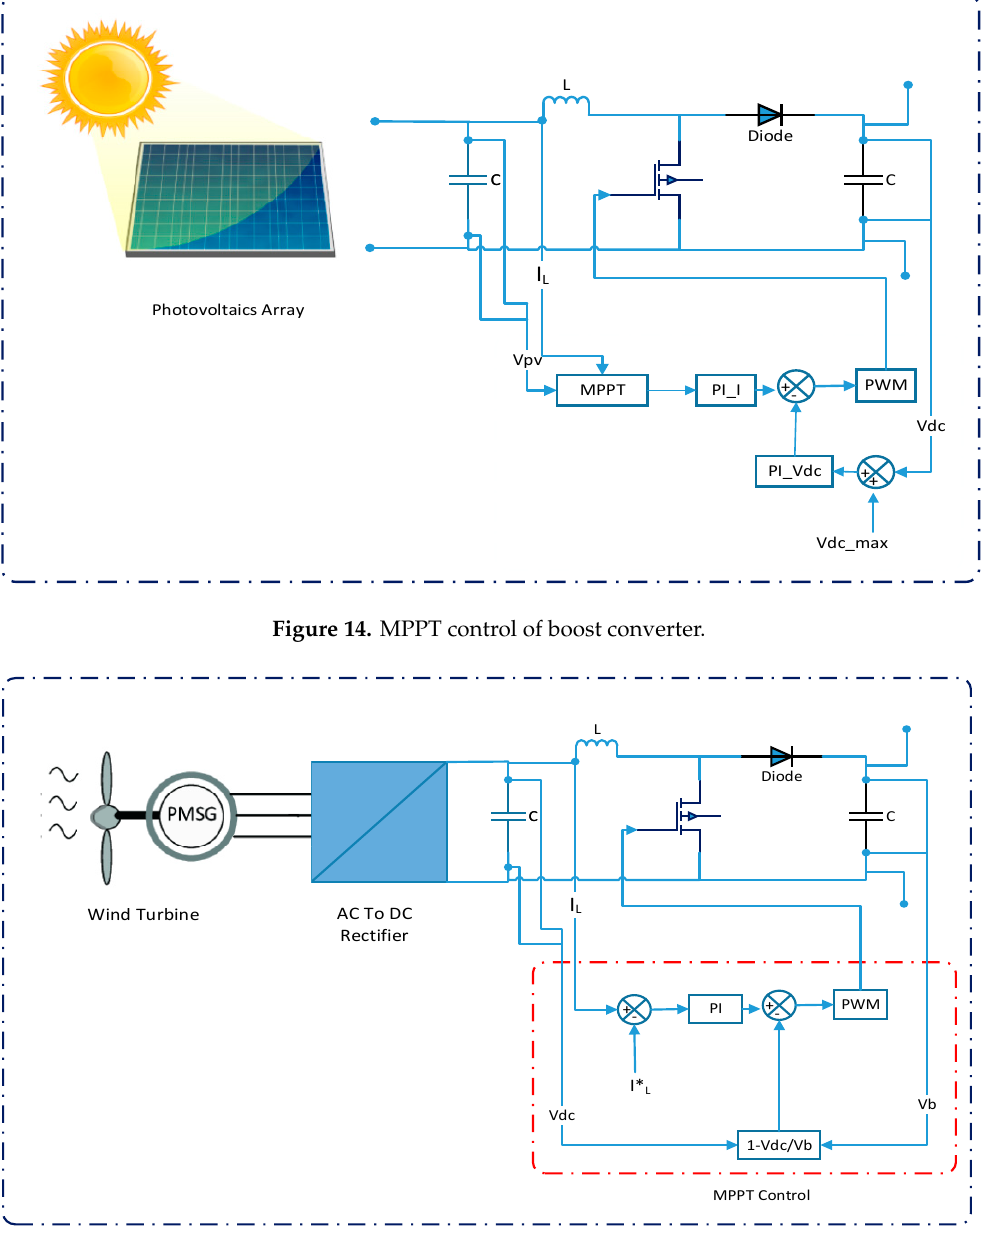
Figure 15. The control of the WT converter.